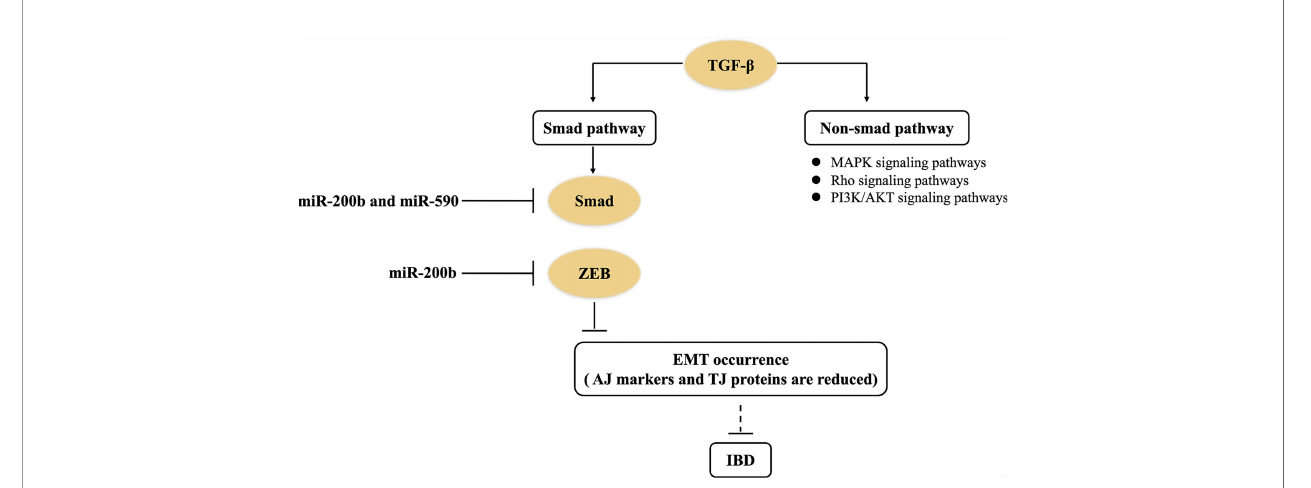
FIGURE 3 | miRNAs control the TGF- b signaling pathway in IBD. miR-200b downregulates the expression of target genes (including Smad2, ZEB1, and ZEB2) to inhibit EMT occurrence in the TGF- b 1/Smad signaling pathway of IBD. miR-590 negatively regulates Smad2 and Smad3 in the non-Smad-dependent TGF- b signaling pathway of